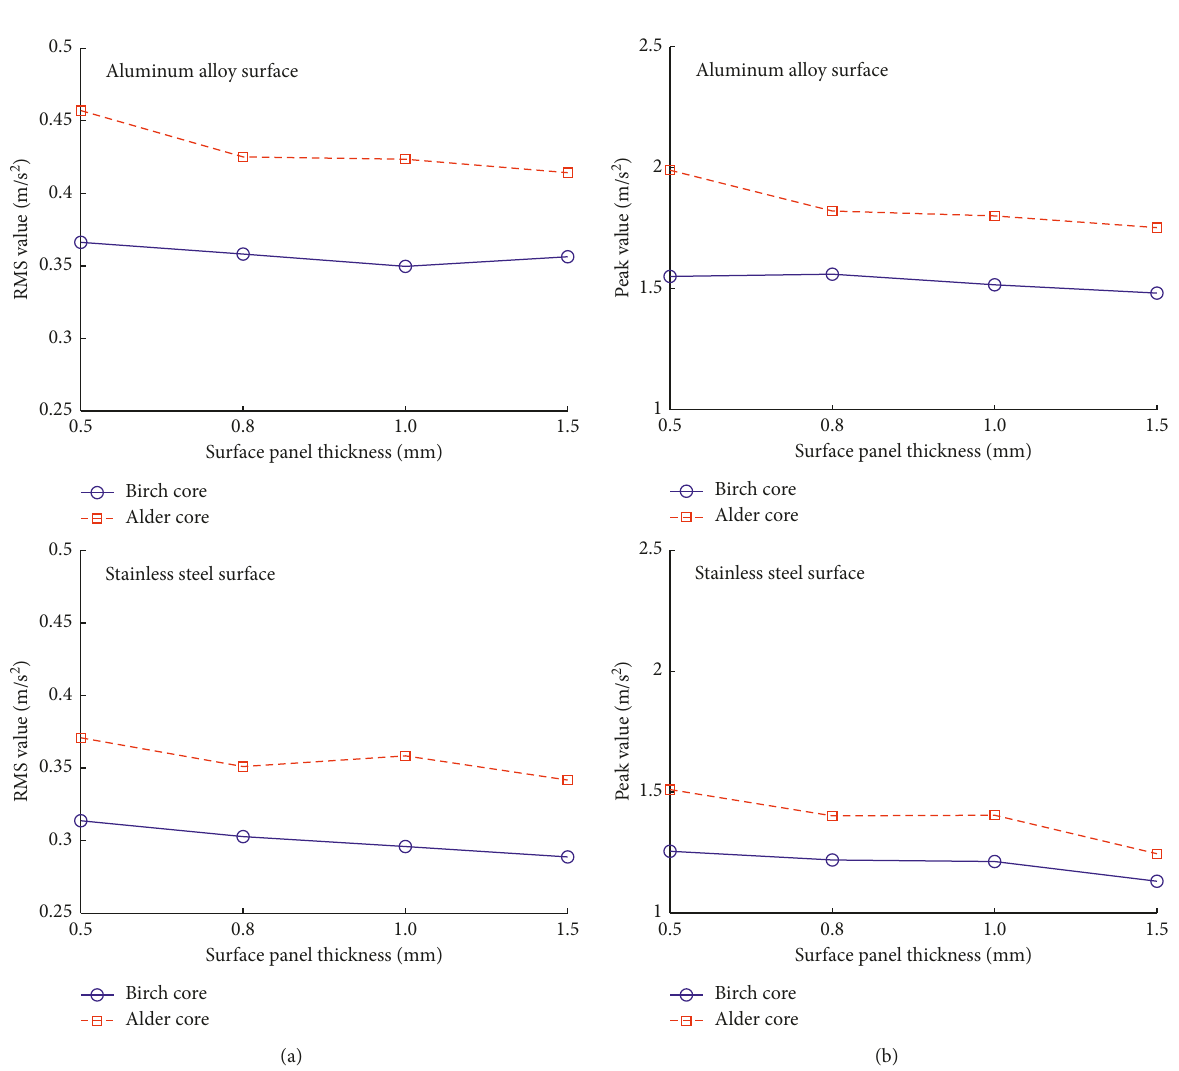
Figure 17: Vibration acceleration response in time domain. (a) RMS values. (b) Peak